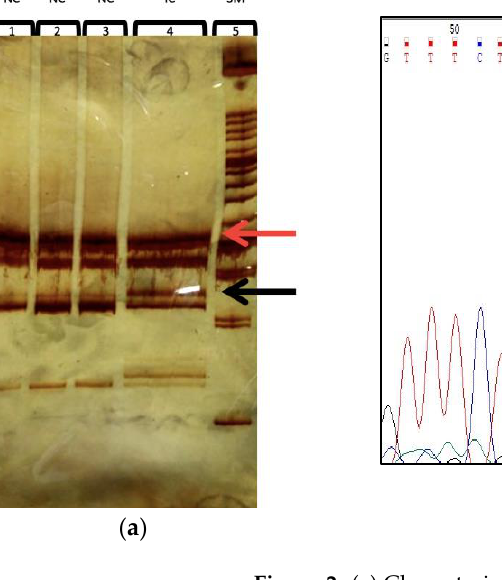
Figure 2. ( a ) Characterization of aberrant splicing fragment. Ten percent polyacrylamide gel elec- trophoresis of MLH1 cDNA RT-PCR analysis of fragment in a normal control (1, 2, and 3) and in the index case (4). Size marker XIV Roche (5). The black arrow indicates the wild-type band correspond- ing to the entire amplified fragment of 523 bp. The red arrow indicates a band with a lower molec- ular weight, which is not present in the negative controls. ( b ) MLH1 cDNA sequence analysis of abnormal band showing the skipping of exon 8. The dotted line shows skipping of entire exon 8 (c.589_c.677). NC, normal control; IC, index case; SM, size marker.